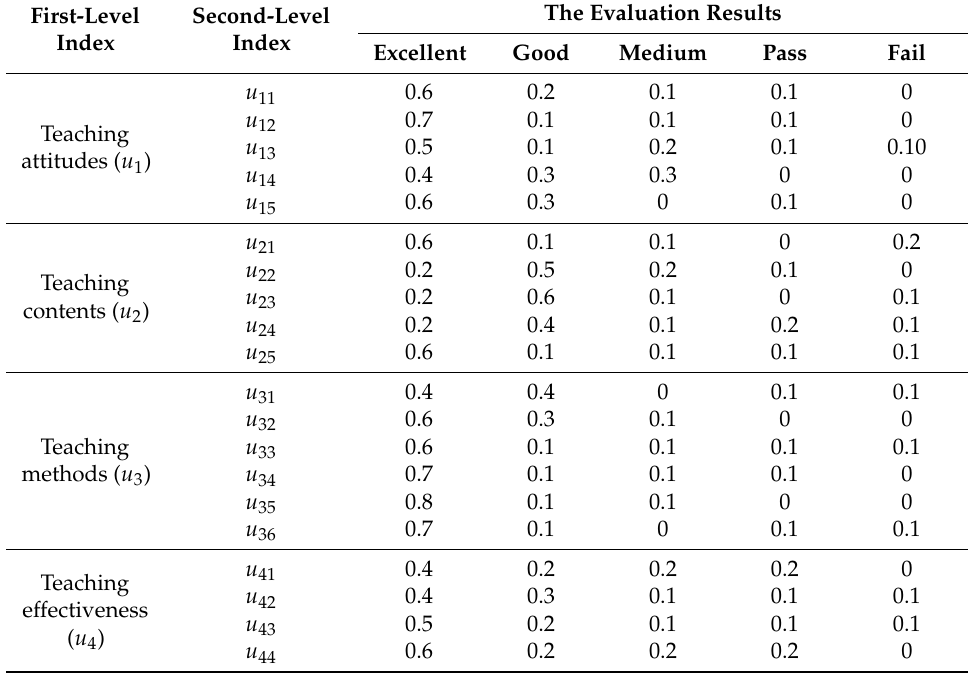
Table 2. The evaluation results for each grade